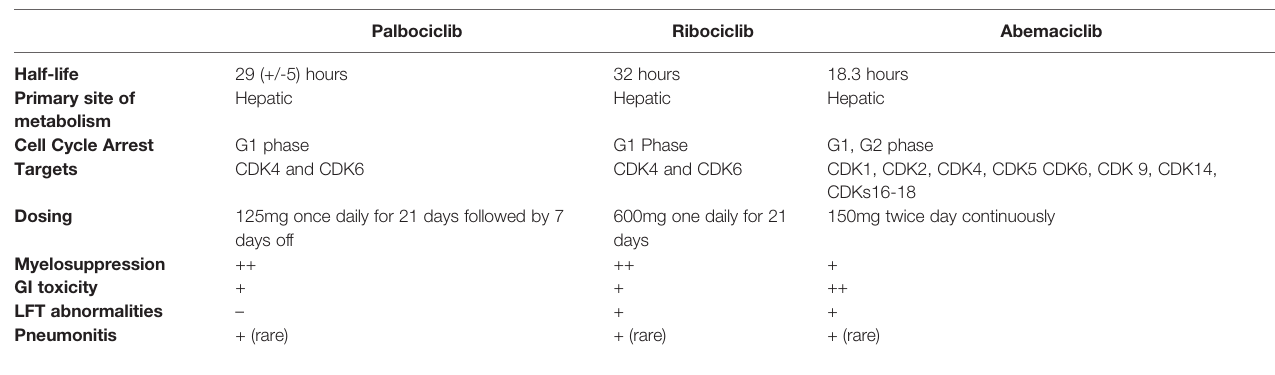
TABLE 1 | Pharmacology of the three approved CDK4/6